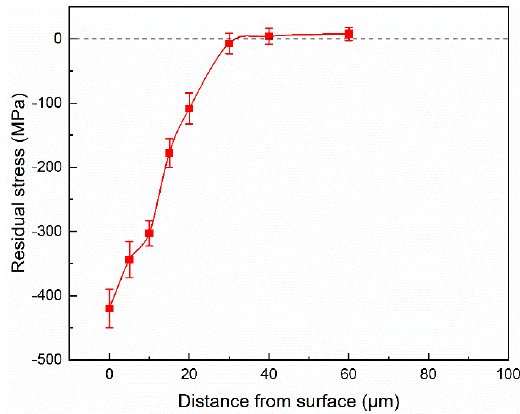
Figure 5. In-depth residual stress of a turned sample.